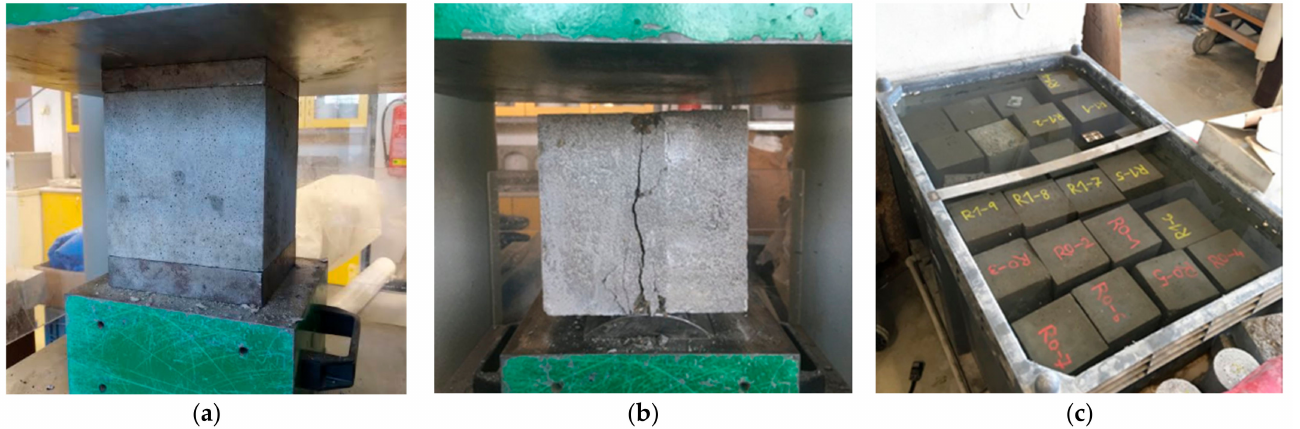
Figure 5. Test specimens before and after the test: ( a ) compressive strength test, ( b ) split tensile test, ( c ) storage of samples in